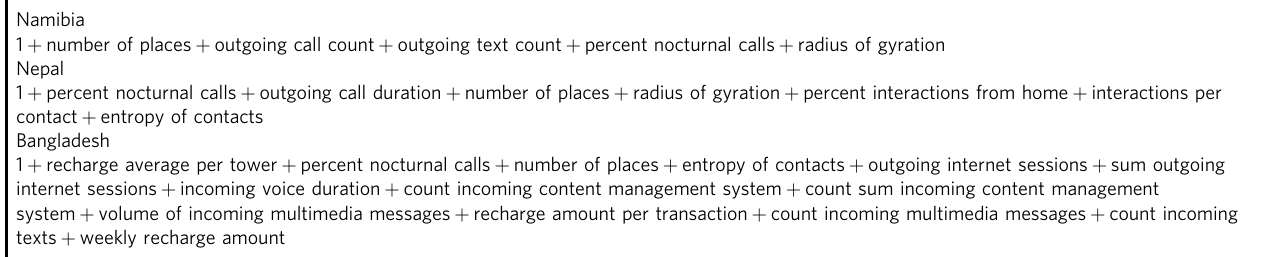
Table 4 Full model speci fi cations for each country. Namibia 1 + number of places + outgoing call count + outgoing text count + percent nocturnal calls + radius of gyration Nepal 1 + percent nocturnal calls + outgoing call duration + number of places + radius of gyration + percent interactions from home + interactions per contact + entropy of contacts